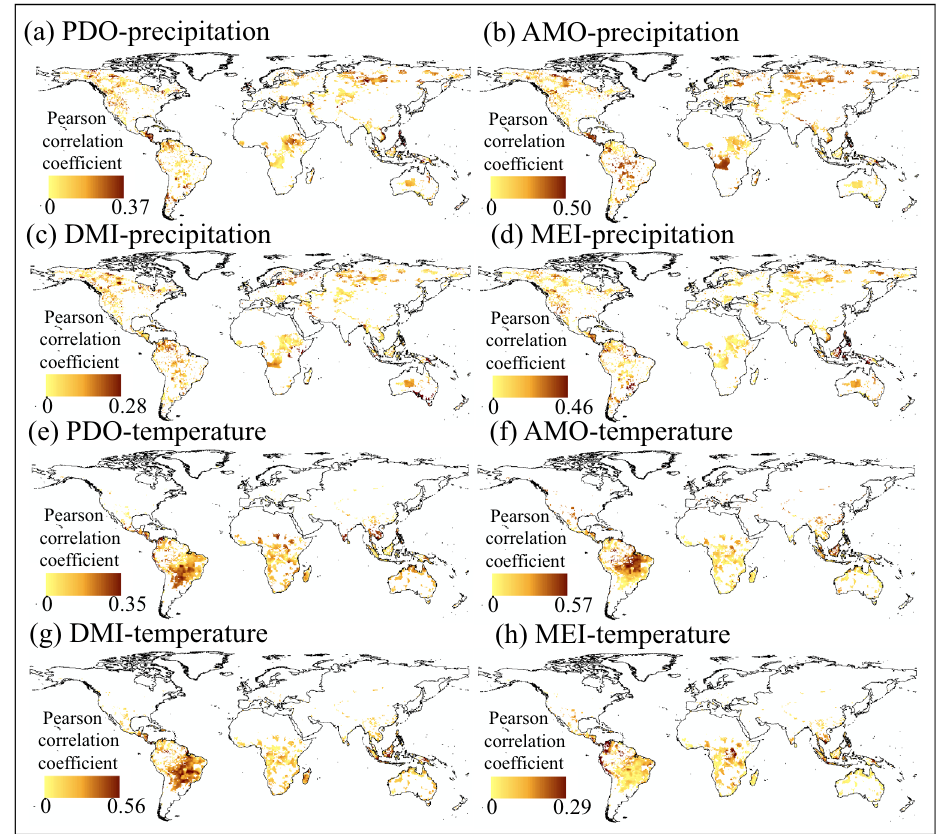
Fig. 8 Distribution map-1 of correlation coefficients of atmospheric–oceanic indices and wildfire-related variables. This dstribution map-1 shows the effects of the four atmospheric-oceanic indices on precipitationand temperature through pearson correlation coefficients. Blank indicates that no wildfires orchange-points have occurred on the grid. PDO: Pacific Decadal Oscillation Index. MEI:Multivariate El Niño-Southern Oscillation Index. AMO: Atlantic Multi-decadal Oscillation Index.DMI: Dipole Mode